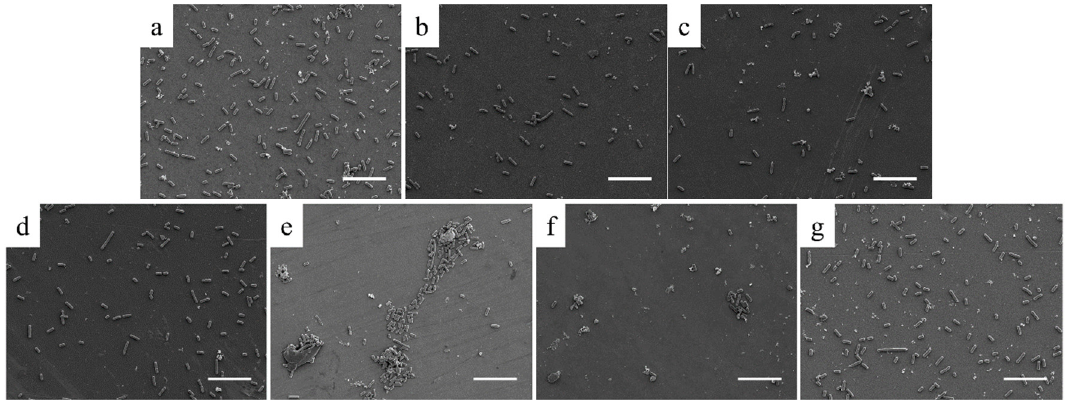
Figure 7. Representative SEM images of E. coli adhering to Ti ( a ), Ti_PEG_cont ( b ), Ti_PEG_2.5_4 ( c ), Ti_PEG_5_4 ( d ), Ti_PEG_5_6 ( e ), Ti_PEG_5_8 ( f ), and Ti_PEG_7.5_4 ( g ). Scale bar represents 10 µm . Another relevant aspect was the differences observed on E. coli fimbriae. These appendages are